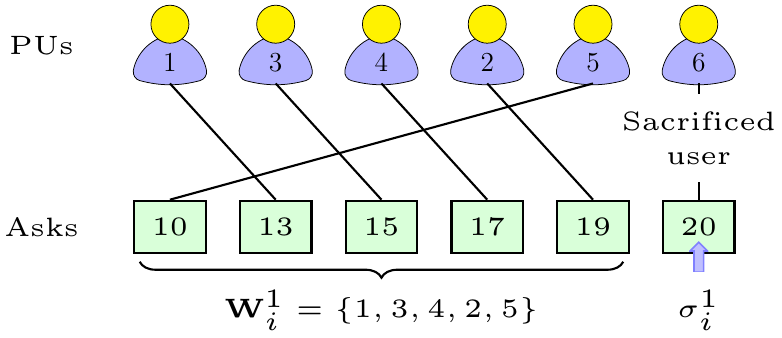
Figure 5. Illustration of the inner-auction